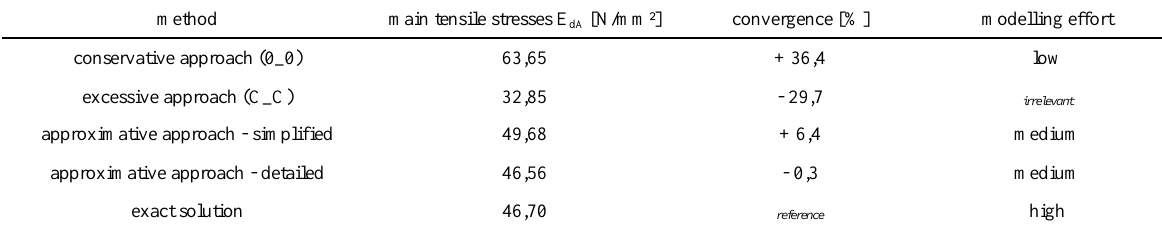
Table 2 Comparison between the different calculation